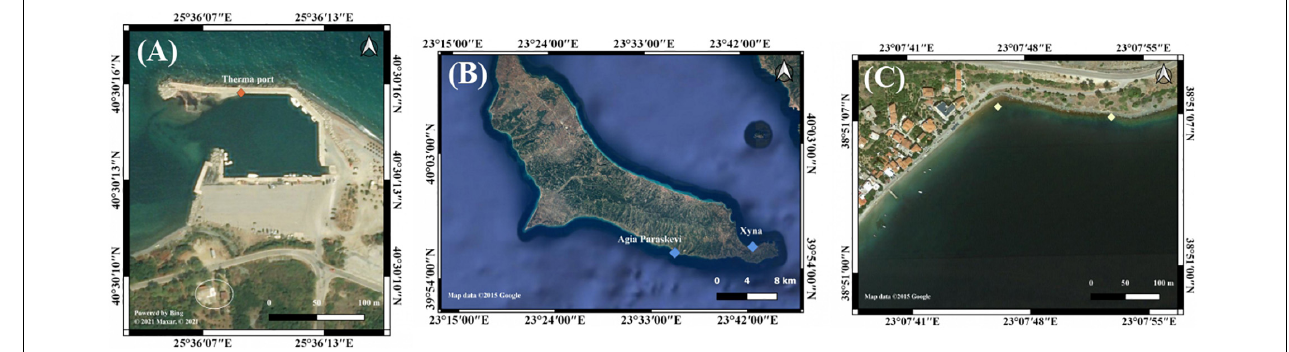
FIGURE 2 | (A) Map of the north section of Samothraki Island that shows the location and name of the emission point. The circled area corresponds to the degassing points of Pigi A and B, and Giotrisi at the hydrothermal system of Therma (Dotsika, 2012; Daskalopoulou et al., 2018a). (B) Map of the Kassandra Peninsula that shows the locations and names of the emission points. (C) Map of the Ilion area (Euboea) that shows the location of the sampling points.